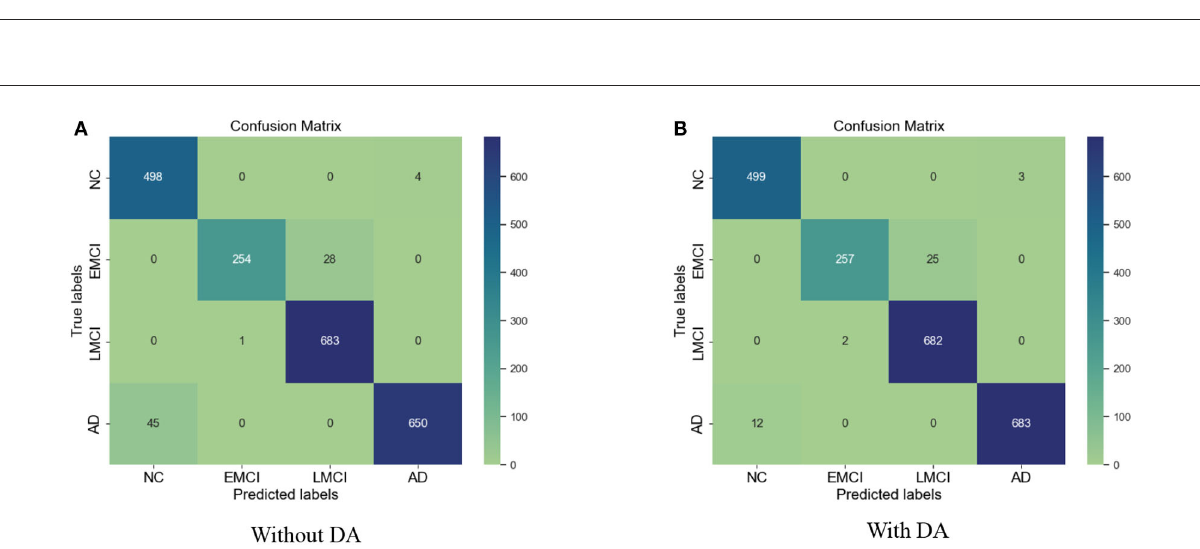
FIGURE4 (A) Training loss and (B) test accuracy of the VGG 16 model with additional layer and freezing the block.